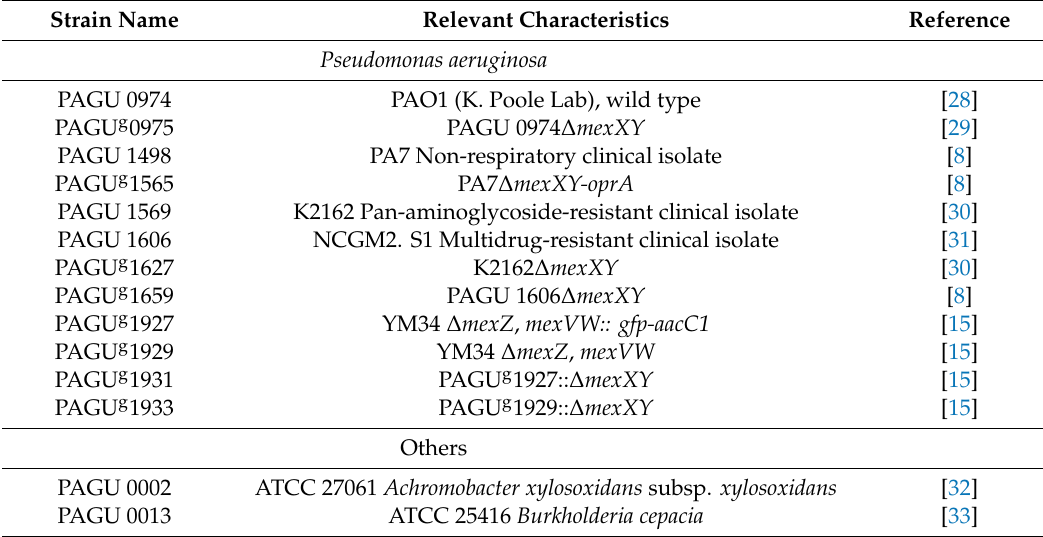
Table 7. Bacterial strains and gene